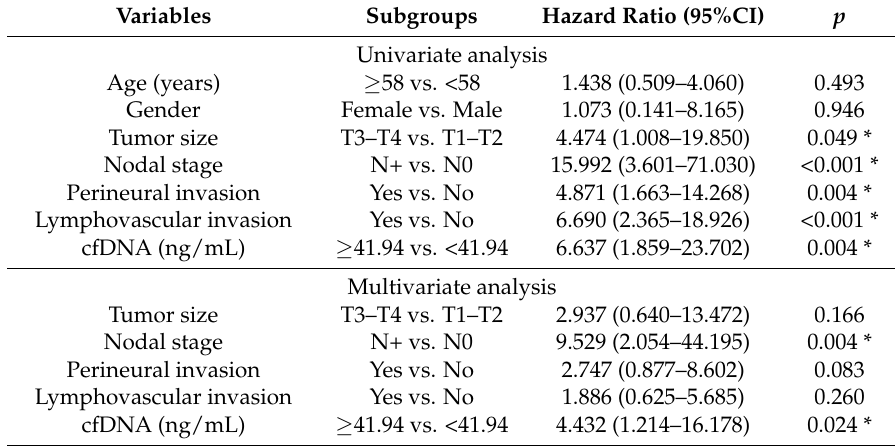
Table 4. Univariate and multivariate Cox regression analysis of disease specific survival in